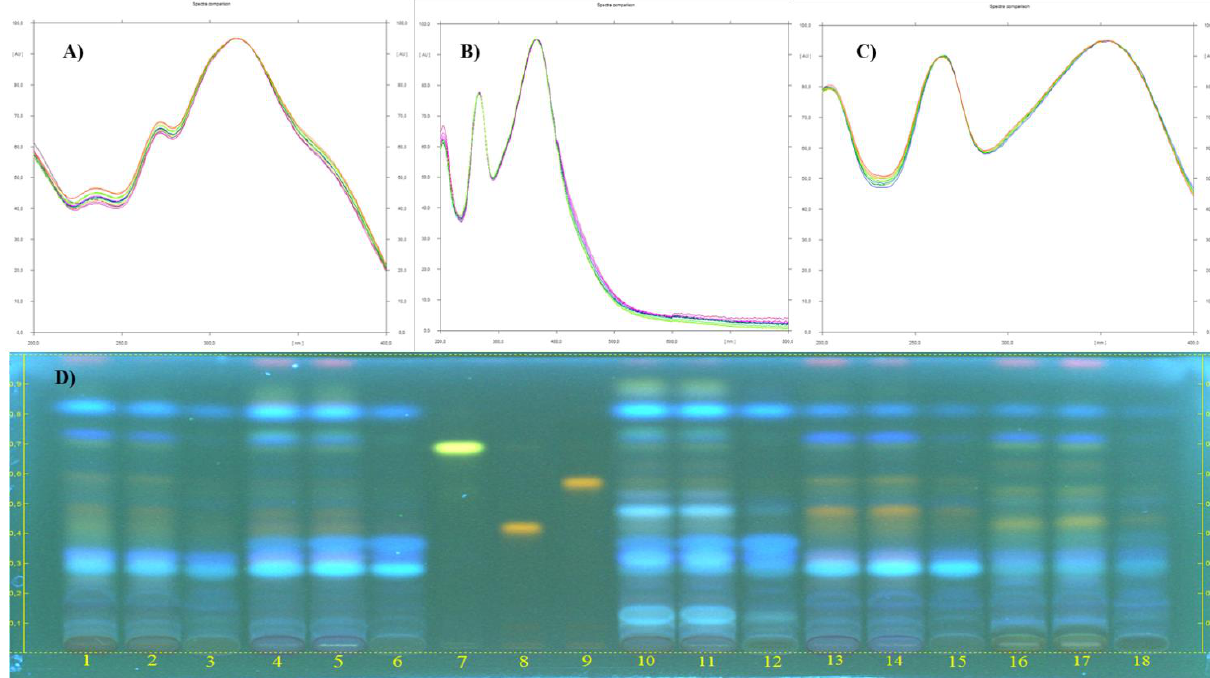
Figure 1. ( A ) Overlay UV spectra of tiliroside and the corresponding spots in the tracks of all extracts. ( B ) Overlay UV spectra of hyperoside and the corresponding spots in the tracks of all extracts. ( C ) Overlay UV spectra of quercitrin and the corresponding spots in the tracks of all extracts. ( D ) HPTLC chromatograms of: 1. CCA ND, 2. CCA PG, 3. CCA IN, 4. CLA ND, 5. CLA PG, 6. CLA IN, 7. Tiliroside (R f ≈ 0.65), 8. Hyperoside (R f ≈ 0.35), 9. Quercitrin (R f ≈ 0.45), 10. CMA ND, 11. CMA PG, 12. CMA IN, 13. CPA ND, 14. CPA PG, 15. CPA IN, 16. CSA ND, 17. CSA PG, 18. CSA IN. Mobile phase: EtOAc/CHCl 2 /CH 3 COOH/HCOOH/H 2 O (100:25:10:10:11); Derivatization: NPR reagent. Visualization: 366